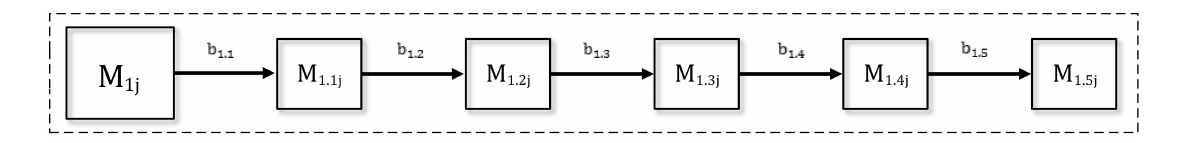
Figure 4. Oriented graph “Threats of the impact of the cyberattacks on the resources of the TDTN”.